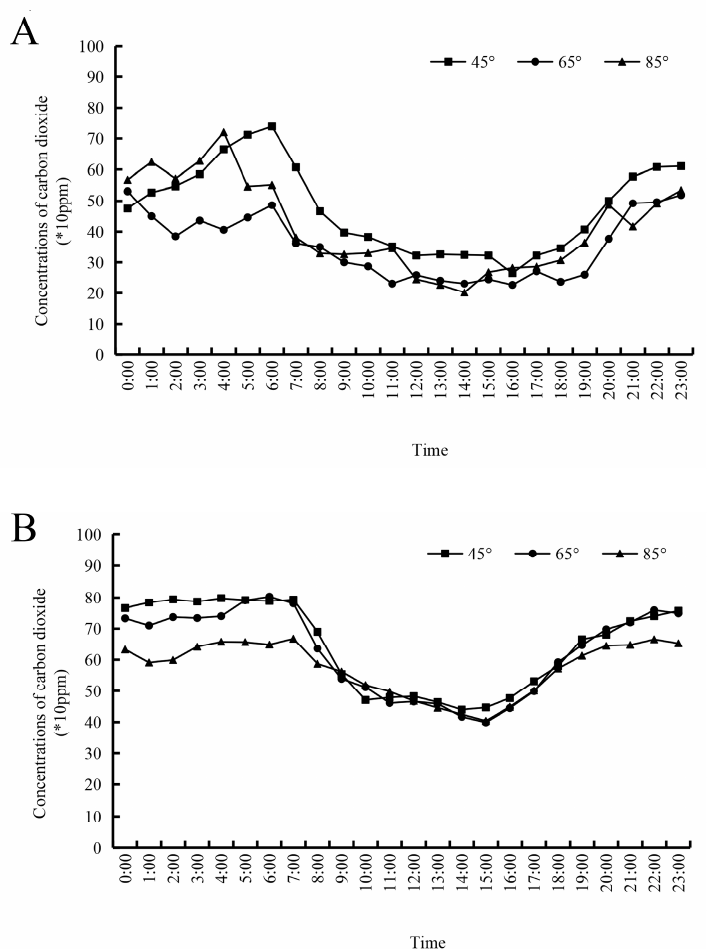
Figure 4. Daily variation patterns of carbon dioxide in summer ( A ) and autumn ( B ) within the canopy of peach trees with different main branch opening angles. * stands for